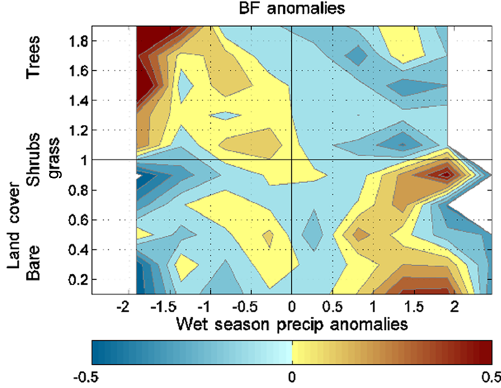
Figure 16. Dependence of fire anomalies on wet season precipita- tion and land cover type in Australia for GFED